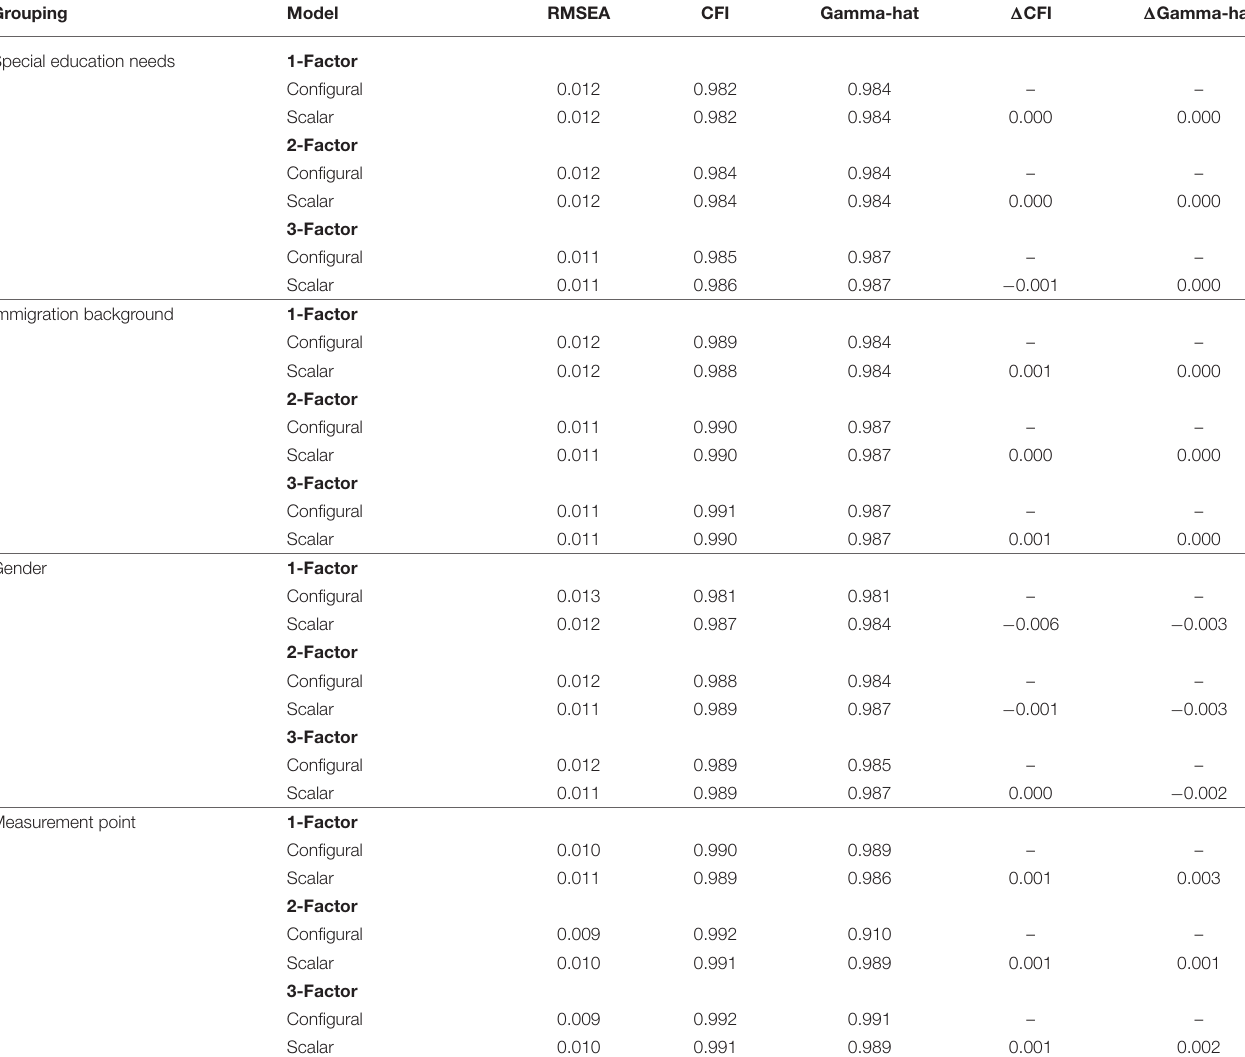
TABLE 3 | Measurement Invariance for 1-, 2-, and